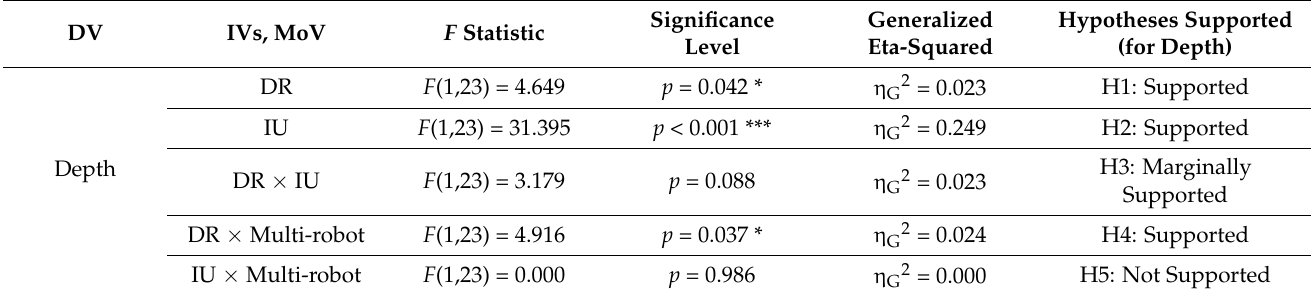
Table 5. ANOVA results for